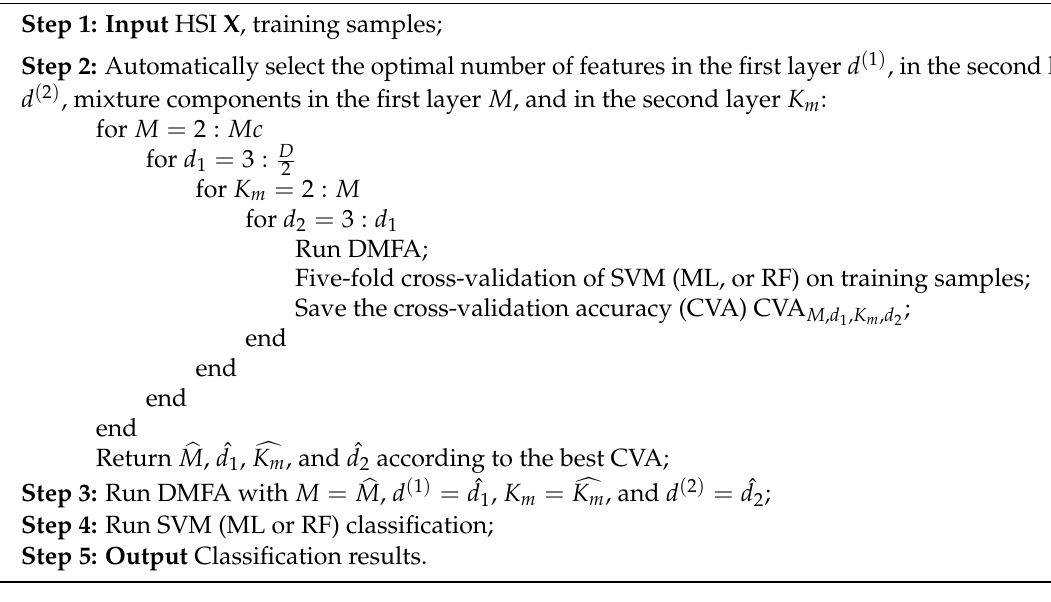
Algorithm 3 Framework based on DMFA